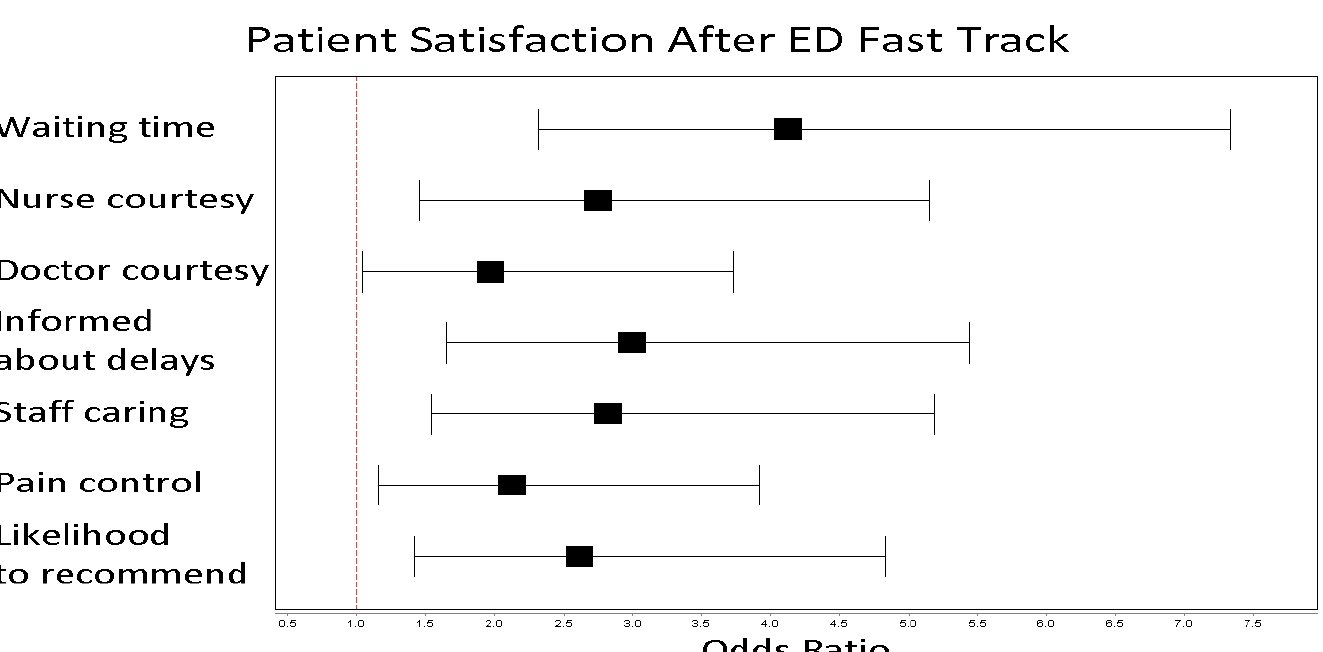
Figure 2. Odds ratio comparison of 100% patient satisfaction responses (5 out of 5 on Press-Ganey Likert scale) after implementation of ED fast